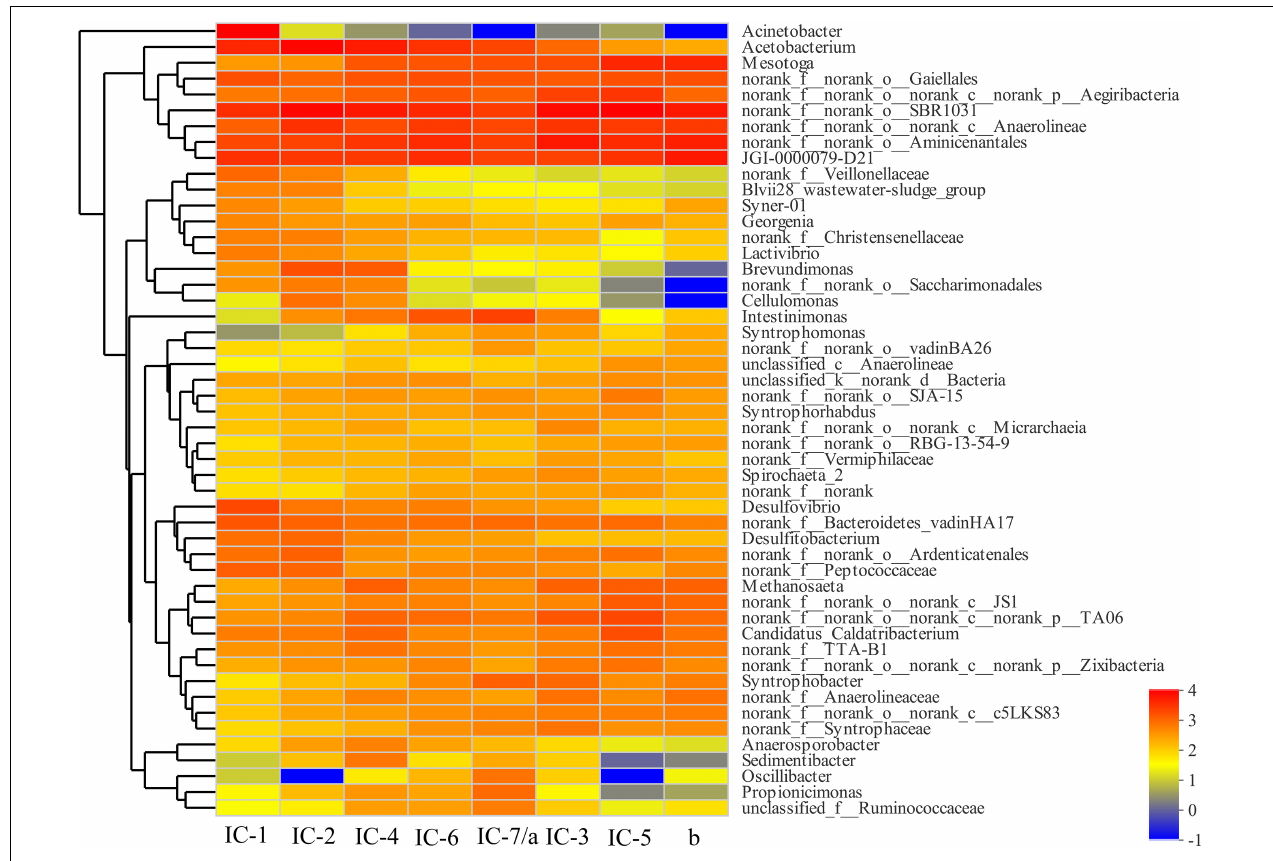
FIGURE 4 | Bacterial heatmap at genus level through Illumina Miseq sequencing. IC-1, IC-2, IC-3, IC-4, IC-5, IC-6, and IC-7 represent the granular samples at OLRs of 1.43, 2.86, 4.29, 5.72, 7.15, 8.58, and 10.01 g COD/L · d. a and b represent sludge samples at different locations of UASB at OLR of 10.01 g COD/L · d.